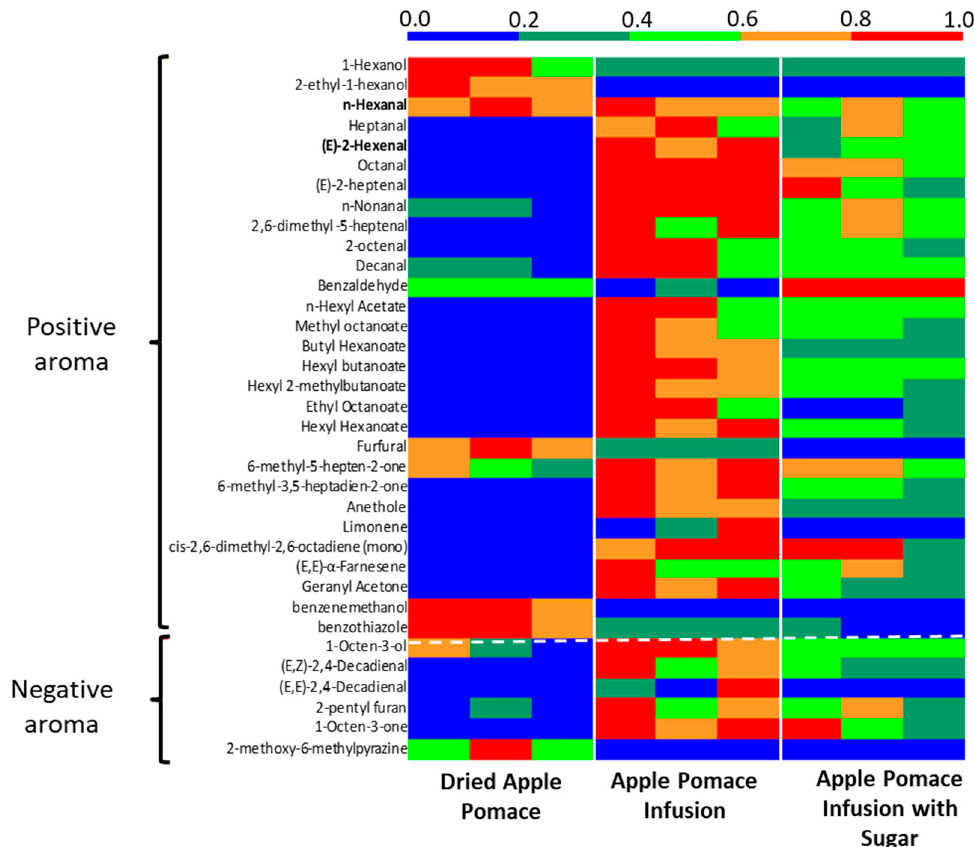
Figure 5. Heatmap of the volatile composition of the dried apple pomace at 80 °C and infusions obtained with dried apple pomace (from January 2014 production) without and with sugar addition. Columns correspond to triplicates of each sample analyzed by HS–SPME/GC–MS. The GC peak area intensity is represented in a blue to red scale normalized between the minimum to maximum areas for each compound.